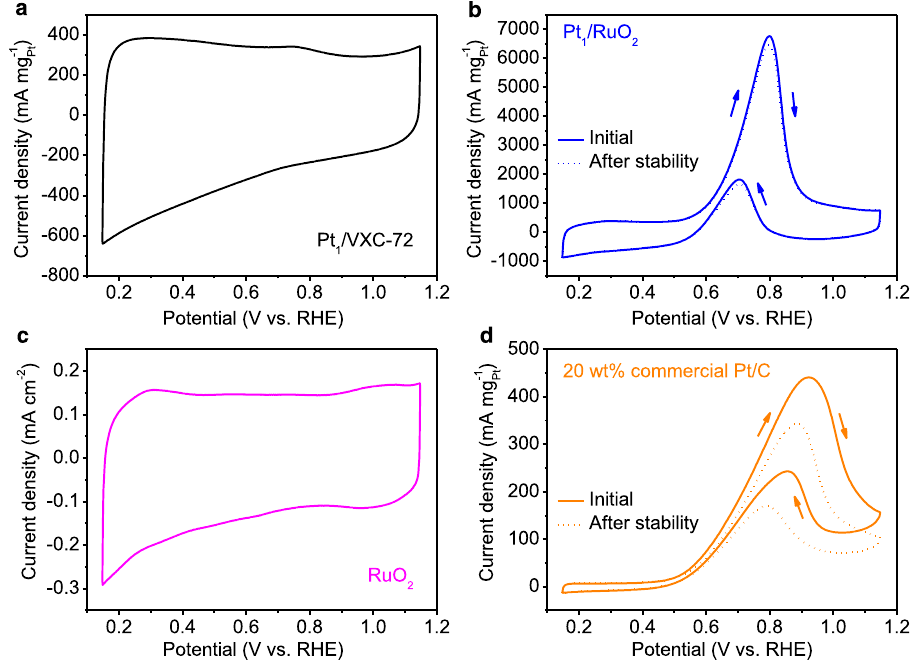
Fig. 3 MOR performance of Pt 1 /RuO 2 and control samples in 0.1 mol L ‒ 1 KOH and 1 mol L ‒ 1 methanol solution at a scan rate of 50 mV s ‒ 1 . a Pt 1